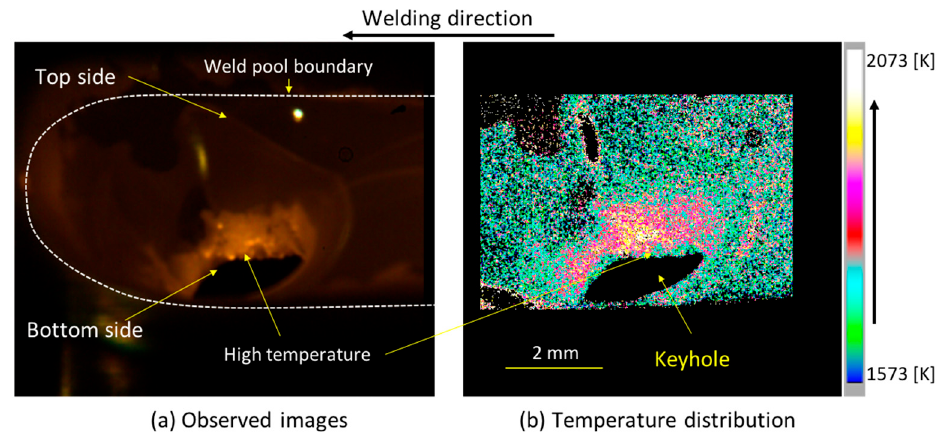
Figure 8. Temperature distribution on the surface along keyhole wall in the case of Ar. ( a ) Observed images, ( b ) Temperature distribution.